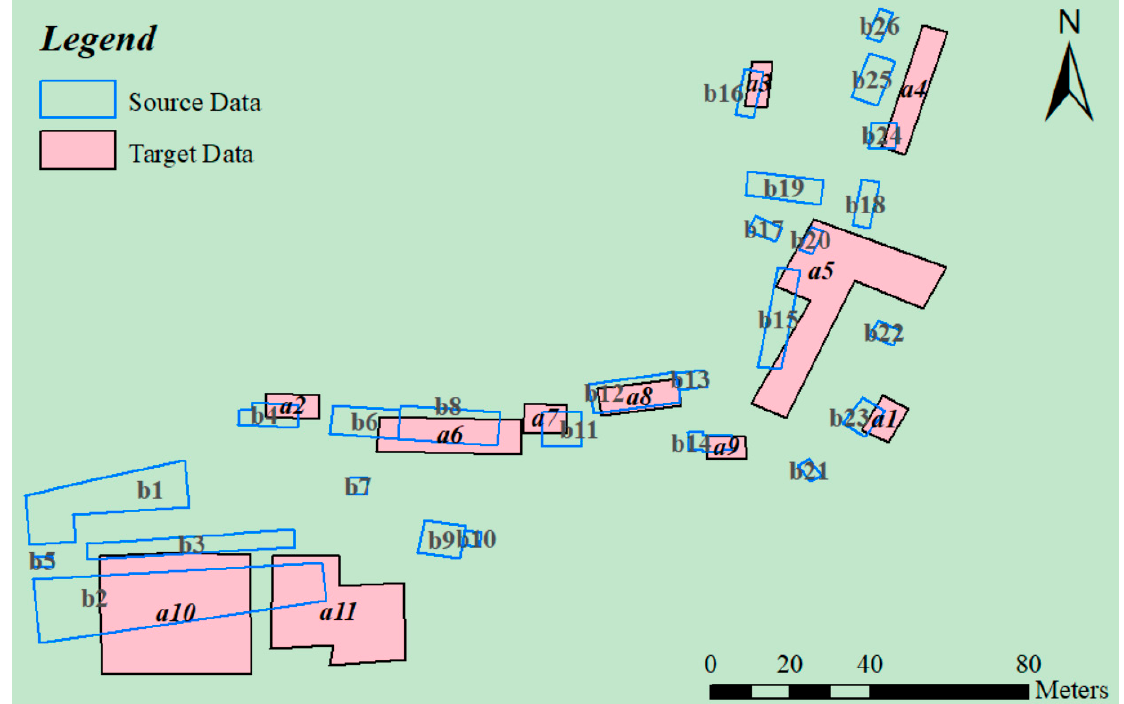
Figure 5. Test data of granularity factor evaluation index (GFEI) index analysis.